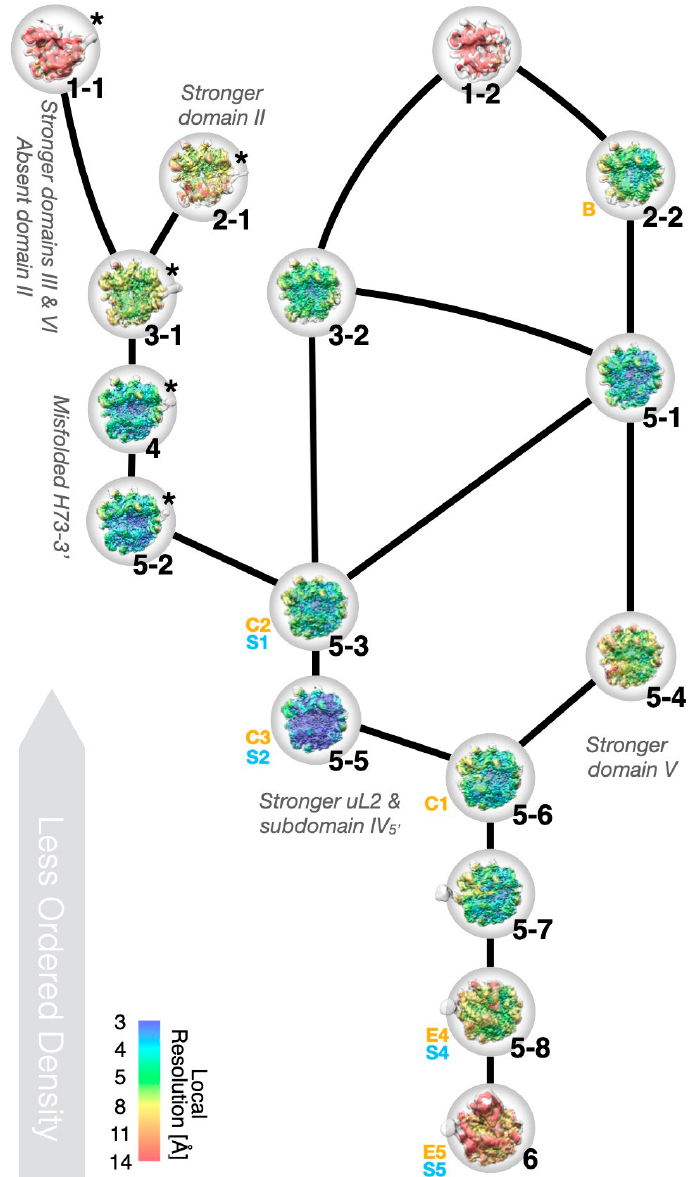
Figure 6. Relations between particle classes. Similar particles are connected by lines, representing possible disassembly paths during salt wash. The right side contains particles with stronger density for domain V, while the left-side particles have stronger densities for uL2, H34–35, and sub-domain IV 5 ′ . The left side-shoot consists of particles with misfolded H73 (asterisks, Figure 5). The particles are shown as in Figure S6. Orange and blue designations are similar classes in Davis et al. [13] and Nikolay et al. [18] (see also Figure S9).